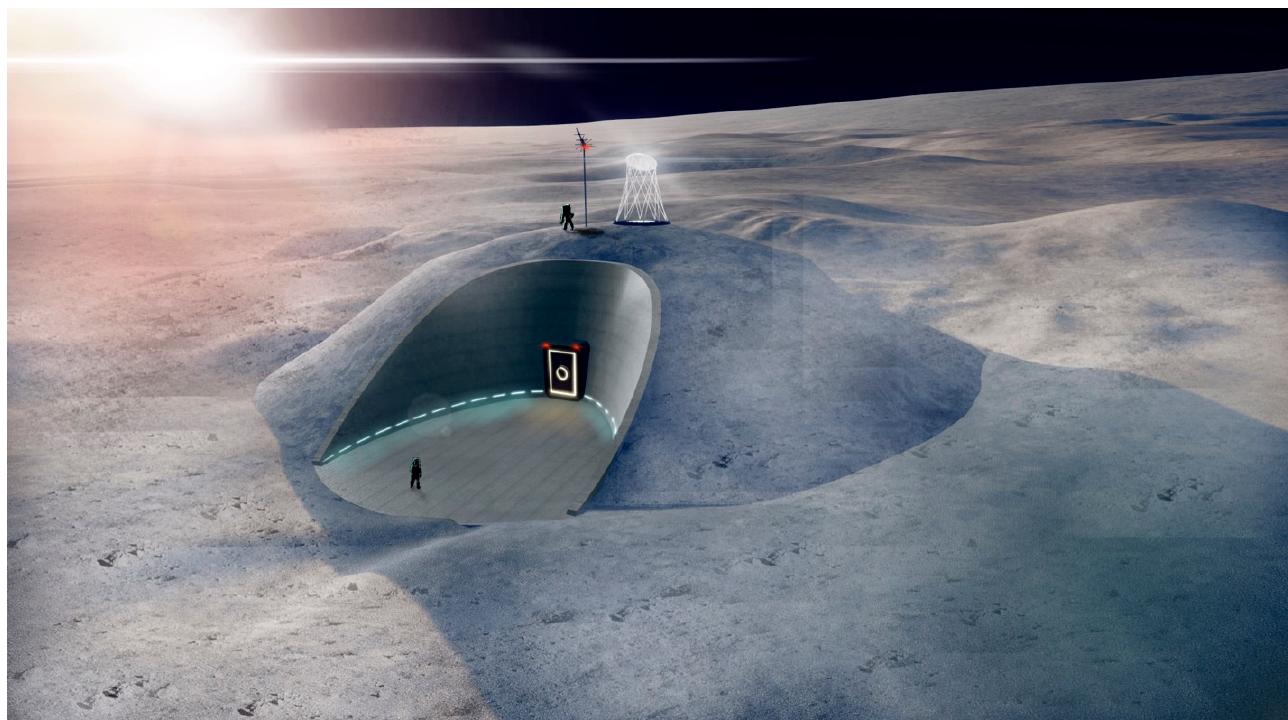
Figure 8. Cross-sectional view of the final variant of one egg-shaped habitat, semi-submerged to an existing crater with a piled-up regolith.